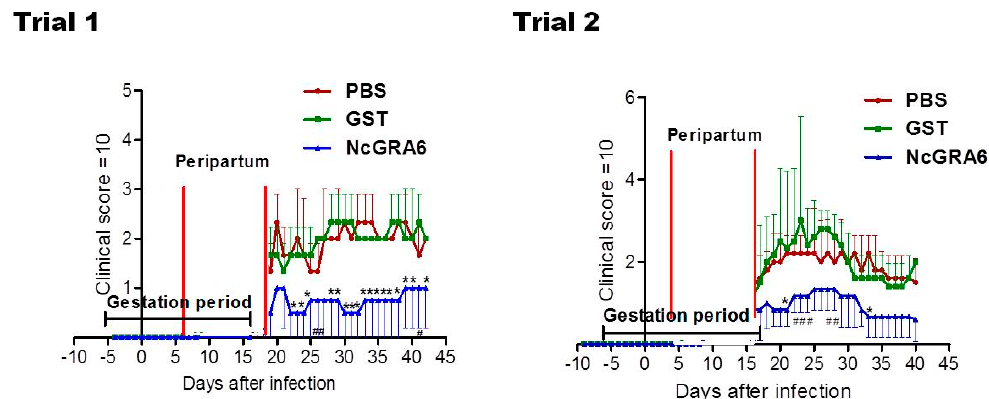
Figure 3. The clinical score observed in pregnant mice. Clinical scores were monitored daily until 30 days after delivery for all mice in each group. The average of all mice in each group was calculated as means ± SD of clinical score values of all mice in a group. The significance of (*) or (#) in the average clinical score was determined with two-way ANOVA plus Bonferroni post hoc analysis ( p < 0.05) of NcGRA6+GST immunized groups against both PBS and GST groups or against PBS group only, respectively.